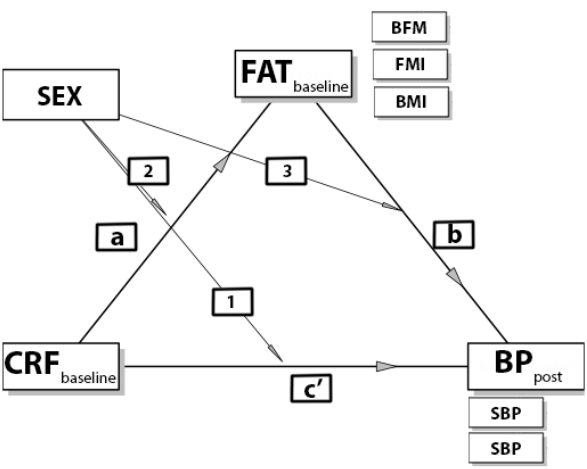
Figure 2. Hypothesized moderation model of potential effects of sex (moderator) on the relationship between CRF and BP through FAT (mediator). Numbers indicate effects of moderation on mediation model’s elements: 1—sex on indirect influence of CRF on BP, 2—sex on the component: CRF effect on FAT (BFM, FMI, BMI), 3—sex on the component: FAT (BFM, FMI, BMI) effect on BP. Letters indicate effects of mediation: c’—direct effect, a—path an of indirect impact, b—path b of indirect impact. Table 2. Interaction terms of sex on the three arms of mediation models (1–3 on Figure 1) in the relationship between CRF and BP (SBP and DBP) through FAT (BFM, FMI, BMI)— p -values. Direct Effect Components